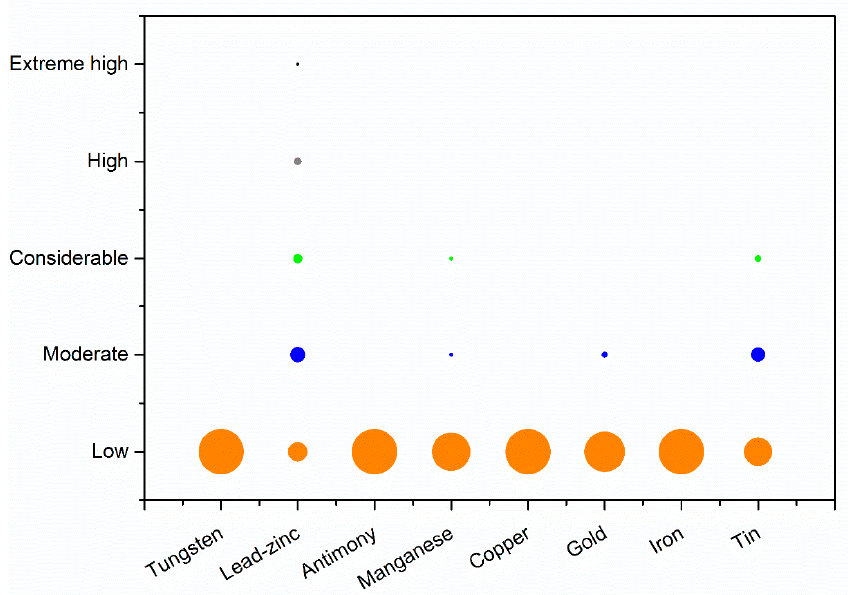
Figure 5. Ecological risk indexes for different types of mines.